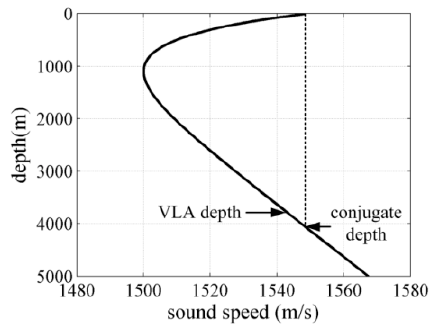
Figure 3. Munk sound speed profile.